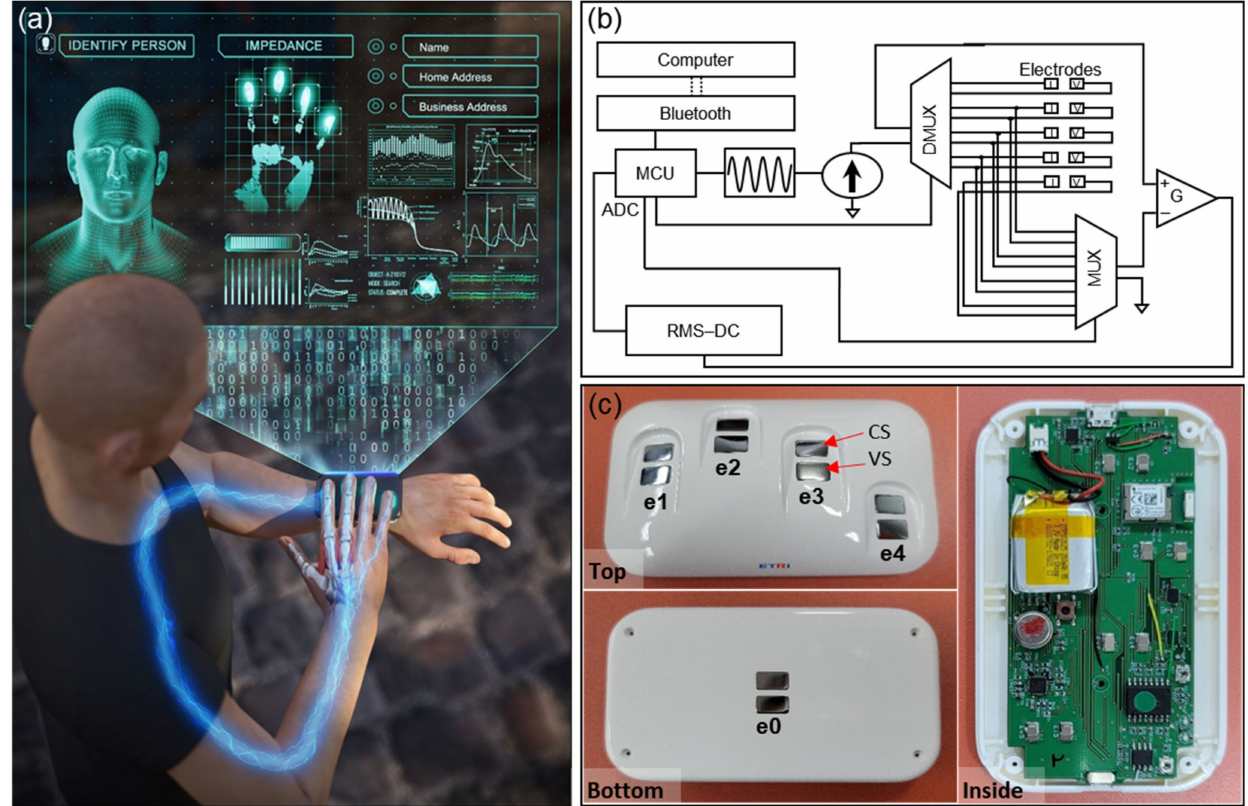
Figure 1. Schematic of wireless wearable electric impedance spectrum identity authentication system. ( a ) Concept of wearable identity recognition system which employs the electrical transfer characteristics through fingers and upper limbs. ( b ) Schematic of the wearable impedance-based identity authentication system. The frequency-modulated sinusoidal current is transmitted sequentially to the electrode pairs by the driving of the multiplexer and demultiplexer, converted to a DC signal by the RMS-DC converter, and then digitized by the ADC of the microcontroller. ( c ) Our developed impedance-based wireless identity authentication module. Numbers 1 to 4 ( e 1 ~e 4 ) are assigned in order from index to little finger electrodes, and number 0 ( e 0 ) is assigned to left wrist electrode mounted under the device. Separate current sourcing (CS) and voltage sensing (VS) electrode pairs for applying four-point electrode measurements were mounted on the